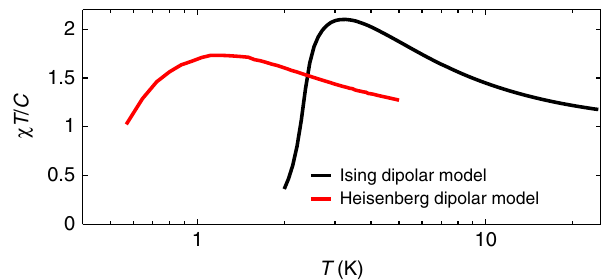
Fig. 6 Susceptibility for the dipolar Ising and Heisenberg models on the cubic lattice. Monte Carlo calculation of χ T / C for the dipolar Ising (1000 spins) and Heisenberg (216 spins) models described by Eq. (6) with J = 0, Da 3 = 1 and S ¼ ± b z i 1